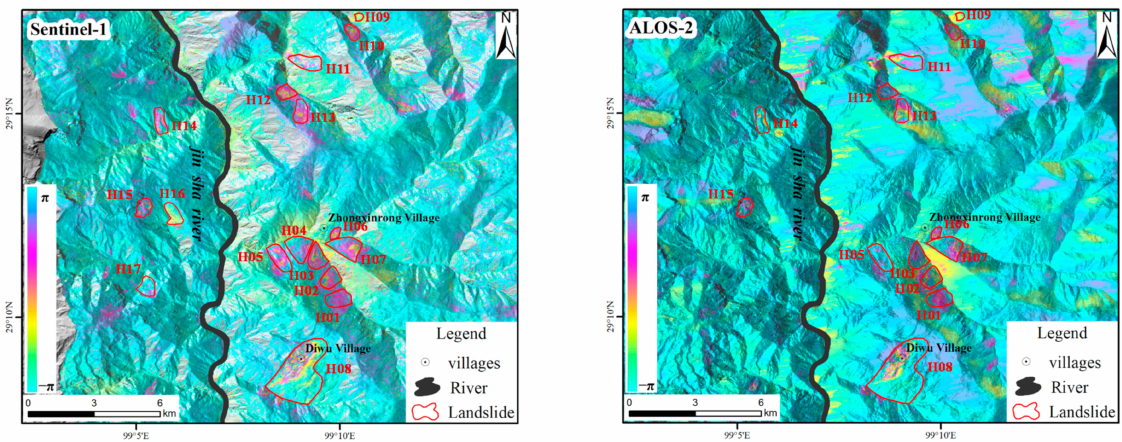
Figure 19. Comparison of Stacking-InSAR results of different waveband data in low-density vegeta- tion coverage areas (left is the result of Sentinel-1 data; right is the result of ALOS-2